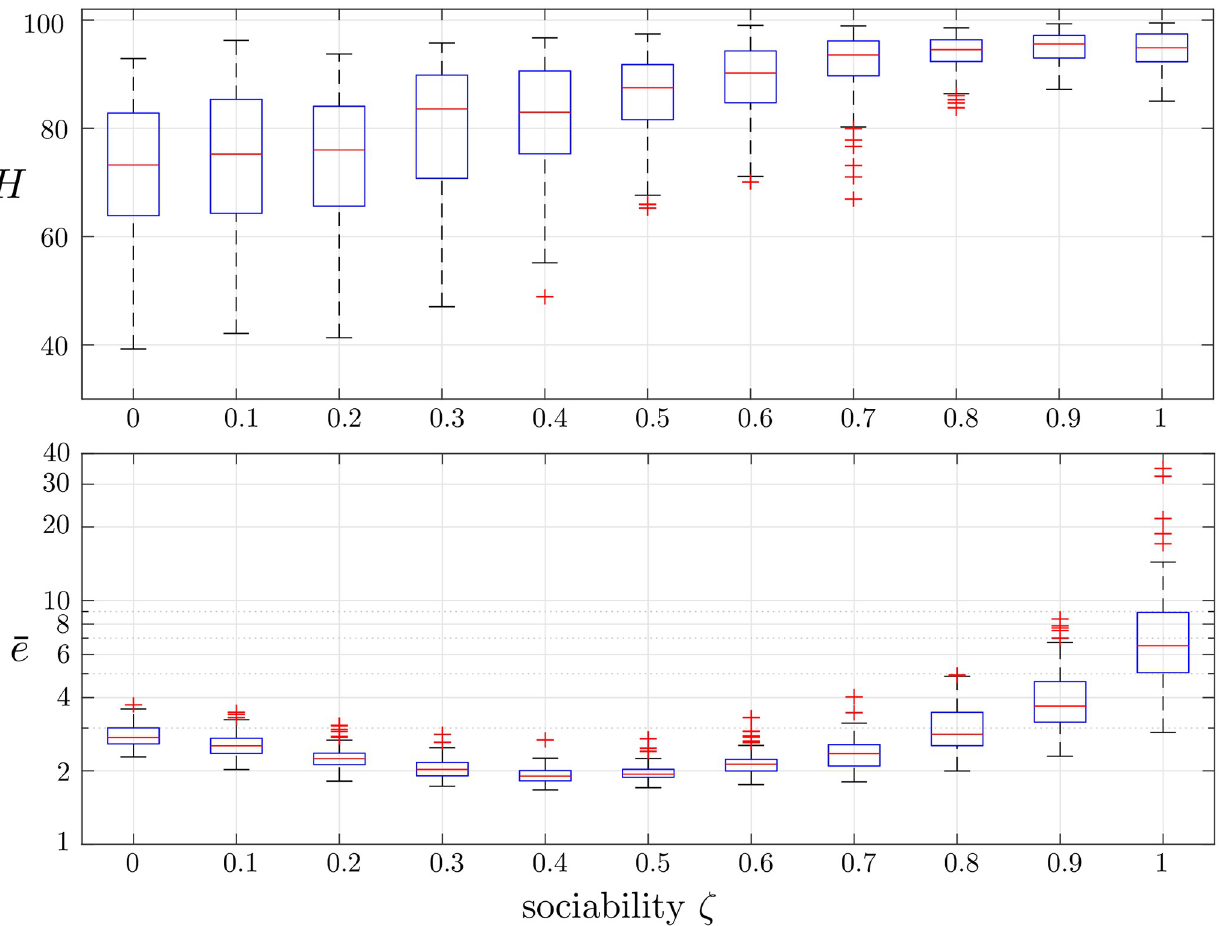
Fig 1. Box plots of the realizations of the herding intensity H (top panel) and the market efficiency � e (bottom panel) obtained with 100 simulations for each value of z .